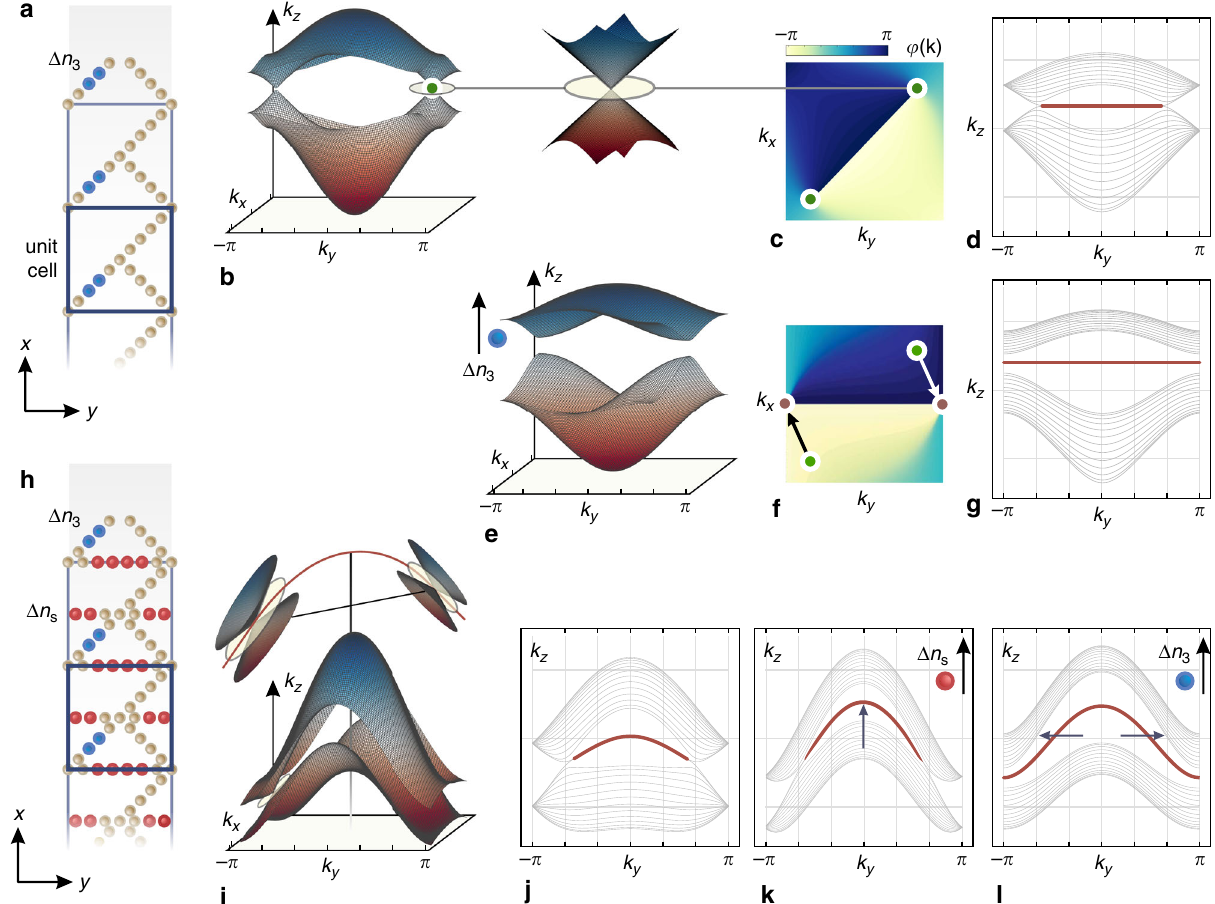
Fig. 2 Ribbon lattice and band structures of in fi nite and terminated systems. a The properly terminated type-I square lattice. The highlighted (blue) sites indicate the waveguides that regulate the hoping term t 3 . They are associated with a variable index difference Δ n 3 . b The bulk band structure corresponding to an in fi nite lattice (both along the x - and y -direction), with a unit cell as shown in a , when Δ n 3 = Δ n 0 . c The Zak phase term ϕ ( k ) indicating that the edge states should appear along the discontinuous ( − π → π ) line. d Band diagram corresponding to the ribbon lattice of a ( Δ n 3 = Δ n 0 ) with the edge states given in red. e – g Bulk band structure, Zak phase term ϕ ( k ), and ribbon band diagram corresponding to a , yet for Δ n 3 = 1.1 Δ n 0 . This higher index value increases the t 3 hopping term, resulting into the relocation of the Dirac cones to the red spots of f . As a result, the edge states extend now throughout the Brillouin zone, as shown in g . h The type-II square lattice where seconary s -chains have been introduced. The red and blue sites indicate the waveguides that regulate t s and t 3 (associated with a variable index difference Δ n s and Δ n 3 , respectively). i , j Bulk and ribbon band structures when all waveguides are identical ( Δ n 3 = Δ n s = Δ n 0 ). The curvature of the edge states in j is associated with the red symmetry line of i . Ribbon band diagram for ( Δ n 3 = Δ n 0 , Δ n = 1.1 Δ n Δ n = Δ n = 1.1 Δ n s 0 ) and ( 3 s 0 ). By perturbing the red and blue highlighted waveguides sequentially, we attain full control over the curvature (in k ) and then extend (in l ) of the edge